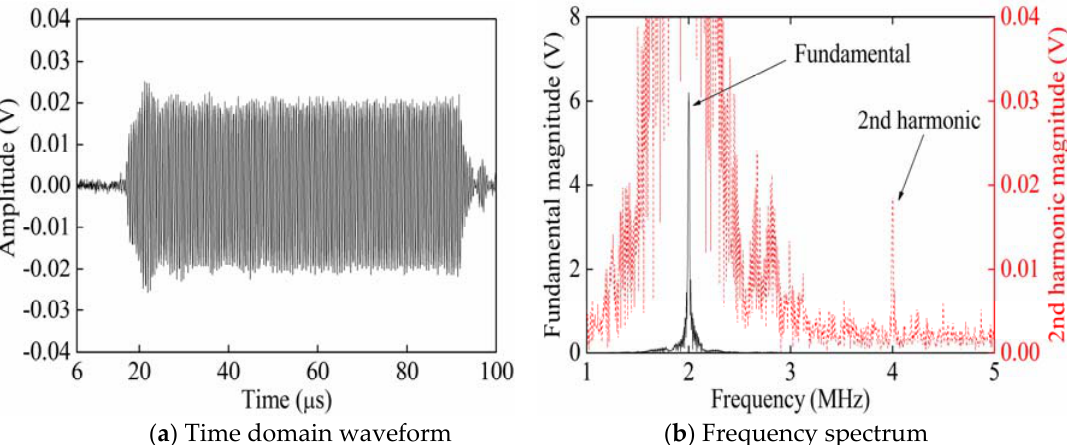
Figure 10. Time domain waveform and frequency spectrum of the received signals when only opening Channel 2.